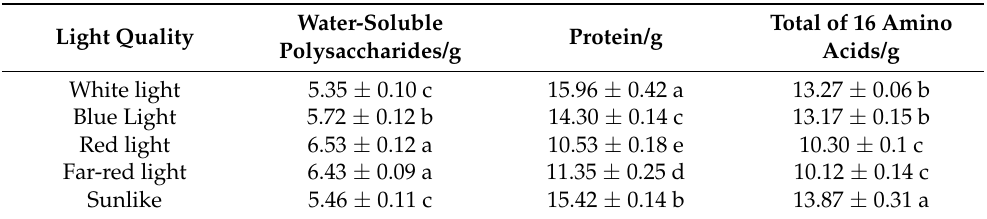
Table 5. Comparison of nutritional quality (in dry weight/100 g) of the P. eryngii fruiting bodies under different light quality